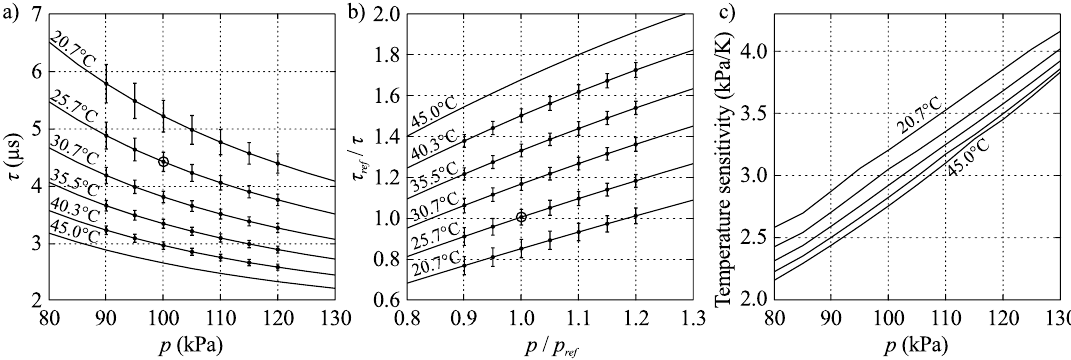
Figure 10. Calibration data. ( a ) Measured points with 95% confidence intervals; ( b ) Best fit to Equation (4) with reference point circled; ( c ) Temperature